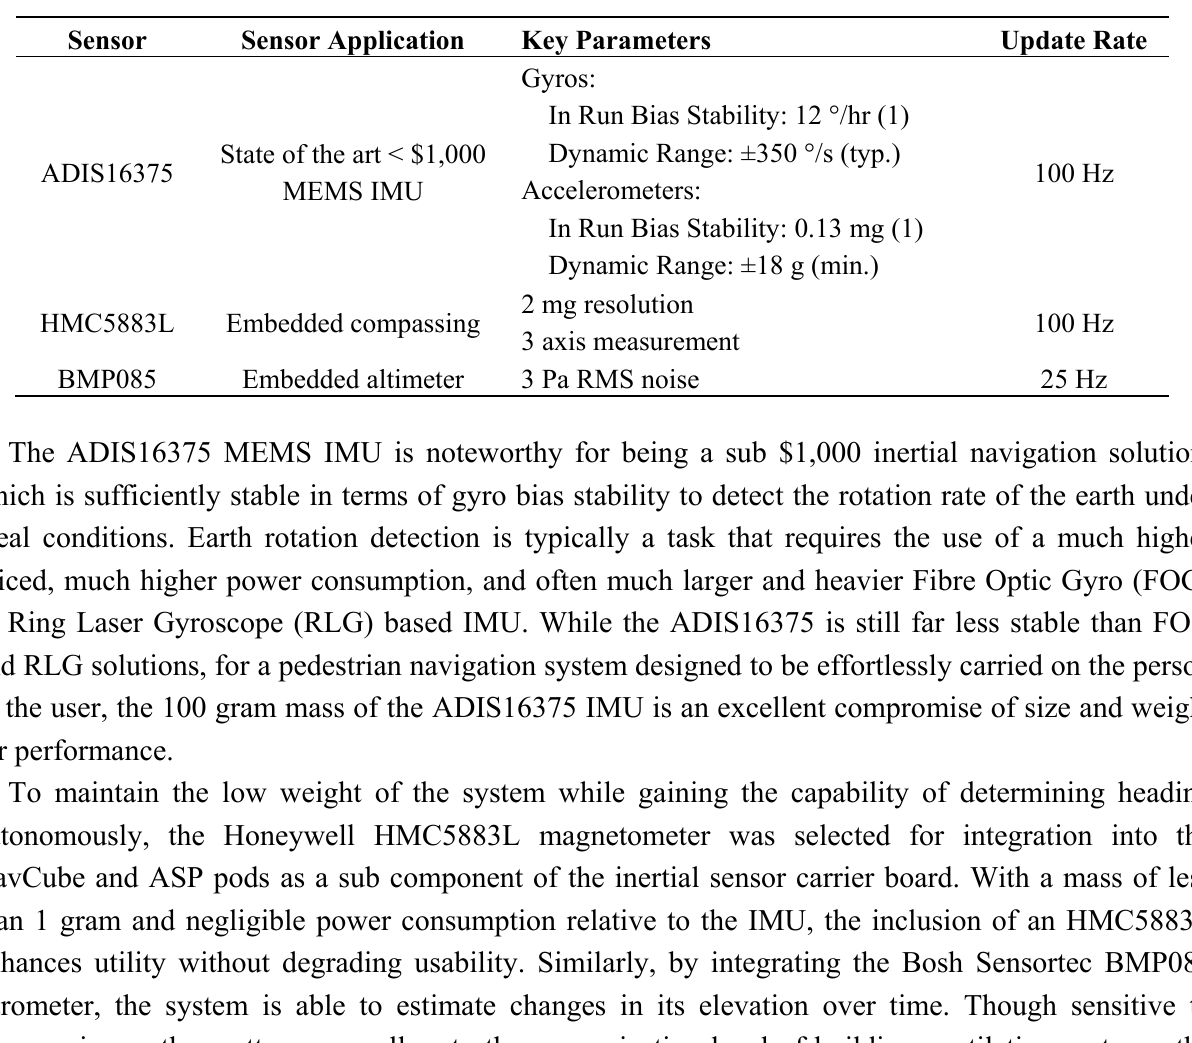
Table 2. Non GNSS NavCube sensors included on internal carrier